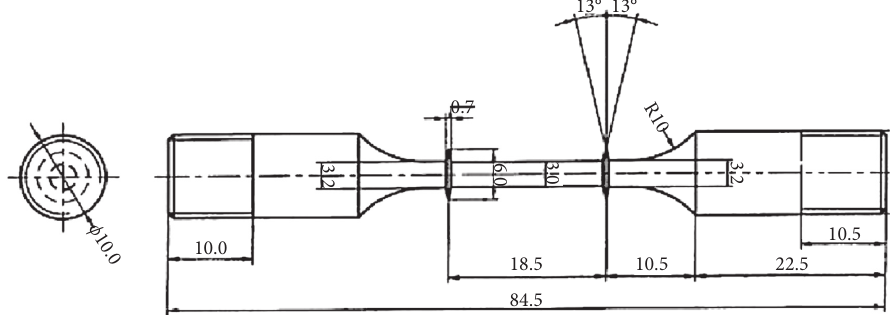
Figure 2: Schematic of the niobium specimen used for creep tests (dimensions in mm).